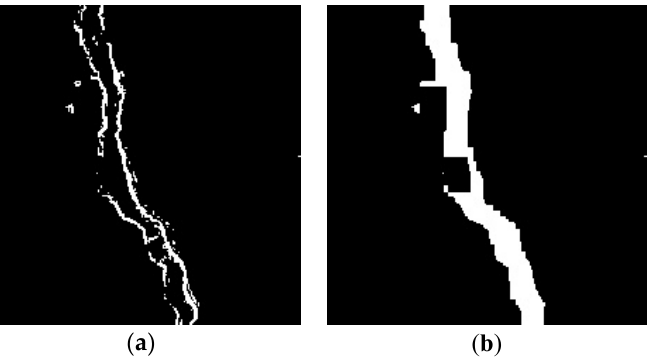
Figure 2. Results of ( a ) thresholding the gradient image; ( b ) performing a closing operation.